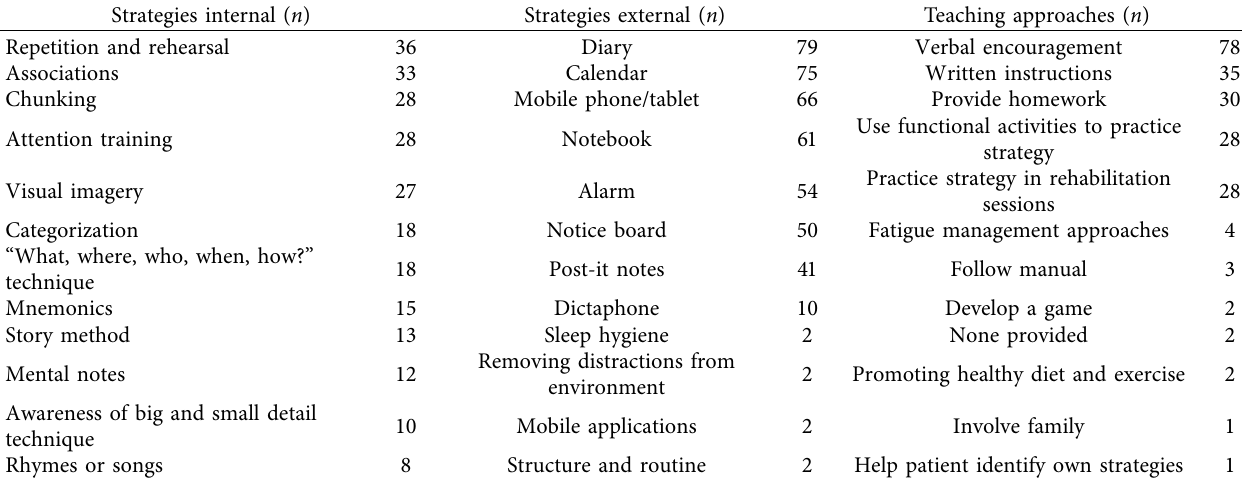
Table 5: Strategies and approaches used by HCPs in cognitive intervention with people with MS.